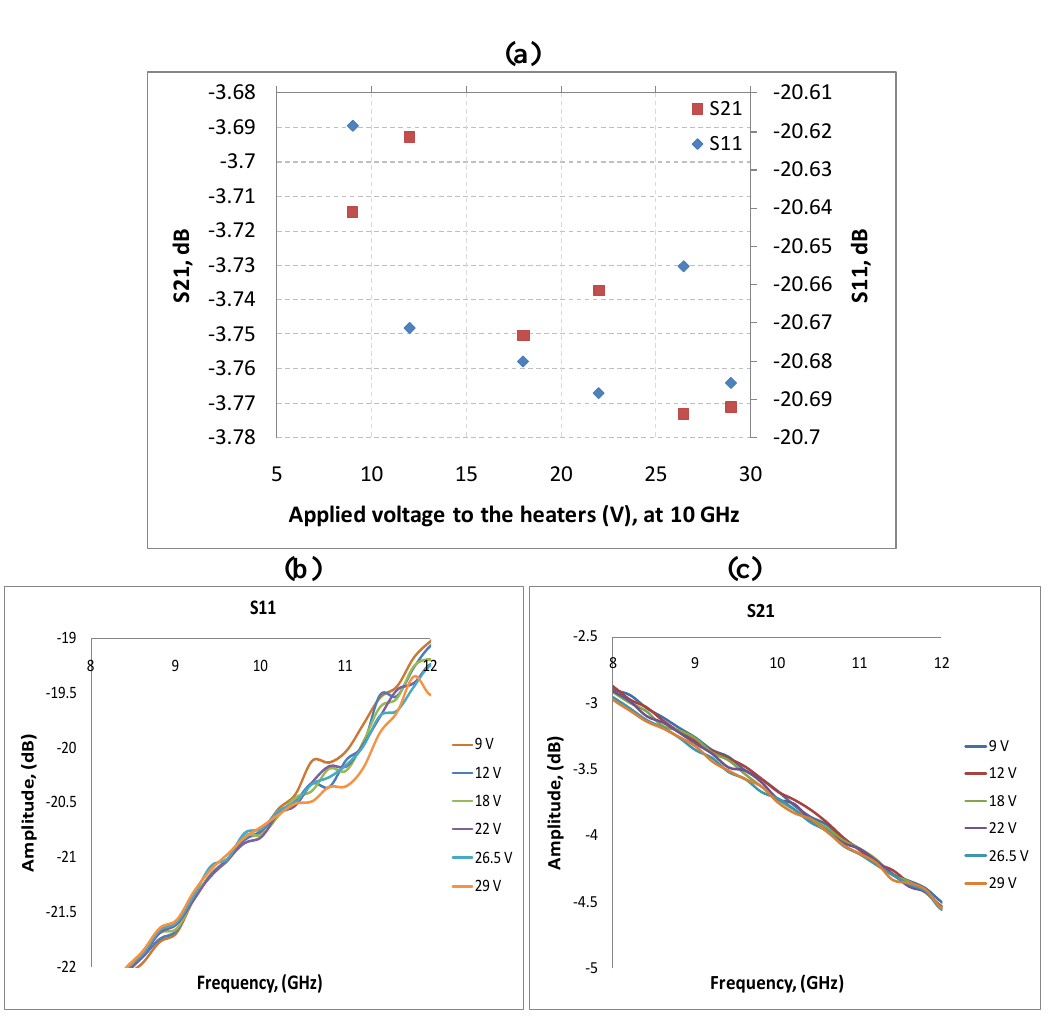
Figure 9. (a) scattering parameters vs. applied voltage to the heaters, f = 10 GHz; (b) S11 in the range of 8GHz to 12 GHz; (c) S21 in the range of 8 GHz to 12